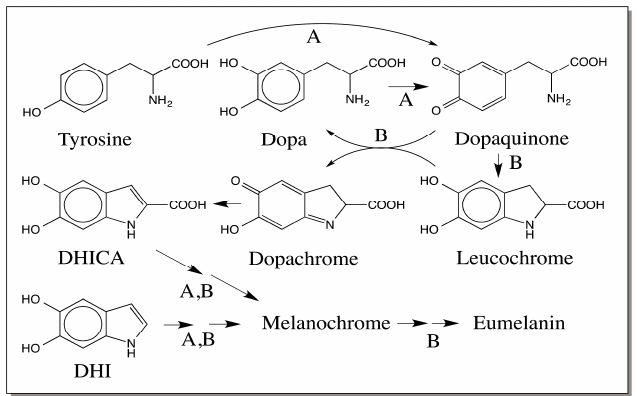
Figure 1. Raper–Mason pathway for the biosynthesis of melanin. The bifunctional enzyme, tyrosinase (A) converts tyrosine and dopa to dopaquinone. Dopaquinone undergoes instantaneous intramolecular nonenzymatic cyclization forming leucochrome, which is rapidly oxidized by dopaquinone to dopachrome. The red colored dopachrome is converted to 5,6-dihydroxyindole (DHI) as the major product and 5,6-dihydroxyindole-2-carboxylic acid (DHICA) as the minor product. Oxidative polymerization of dihydroxyindoles produces the melanin pigment. Tyrosinase is assumed to be the sole enzyme associated with this pathway and the rest of the reactions (B) are presumed to be of nonenzymatic origin.